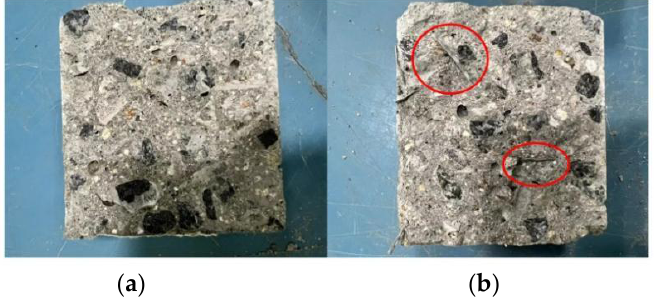
Figure 11. Structural internal morphology of RC concrete with BF and S alone. ( a ) BF 5.5 RC. ( b ) S 0.9 RC.